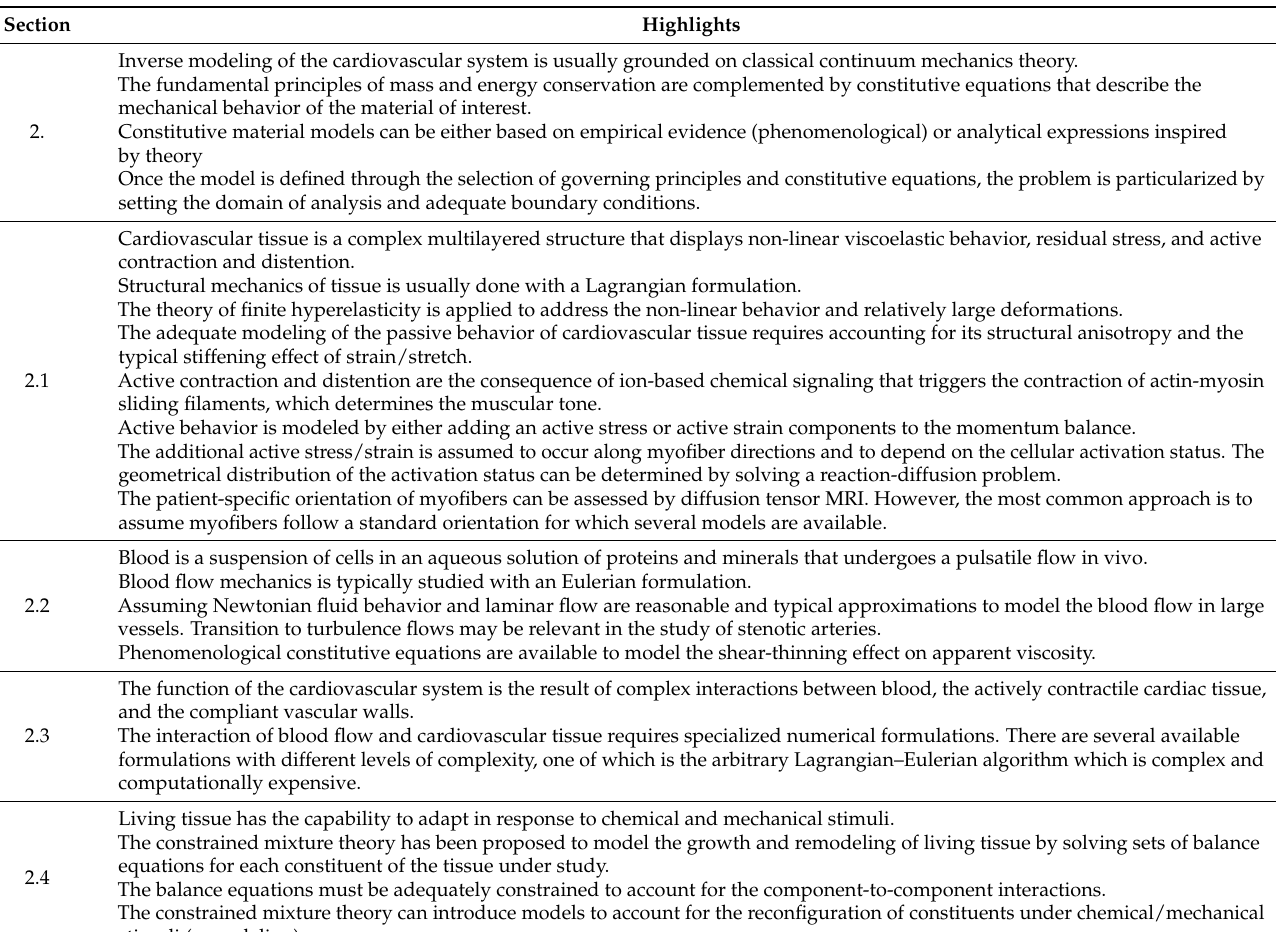
Table 1. Summary of governing principles of